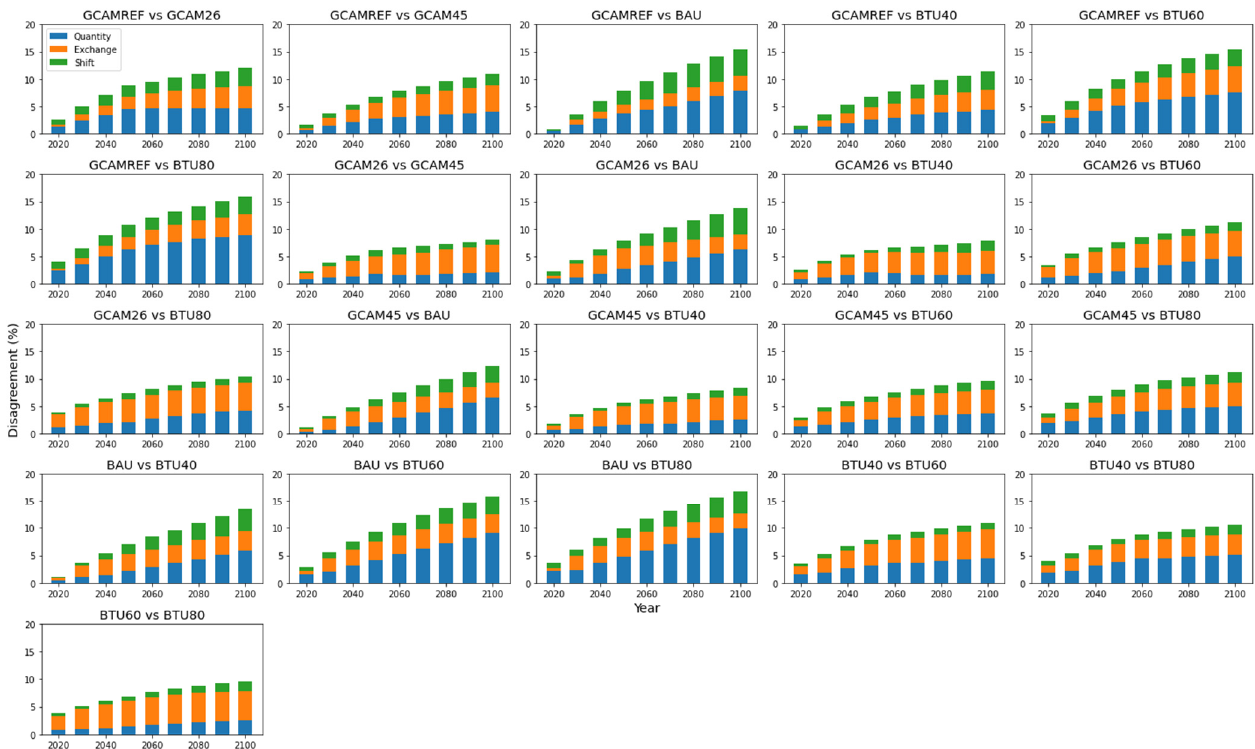
Figure 6. Measures of difference (quantity, exchange, and shift) for all modeled forecasting scenario combinations and all forecasting years.